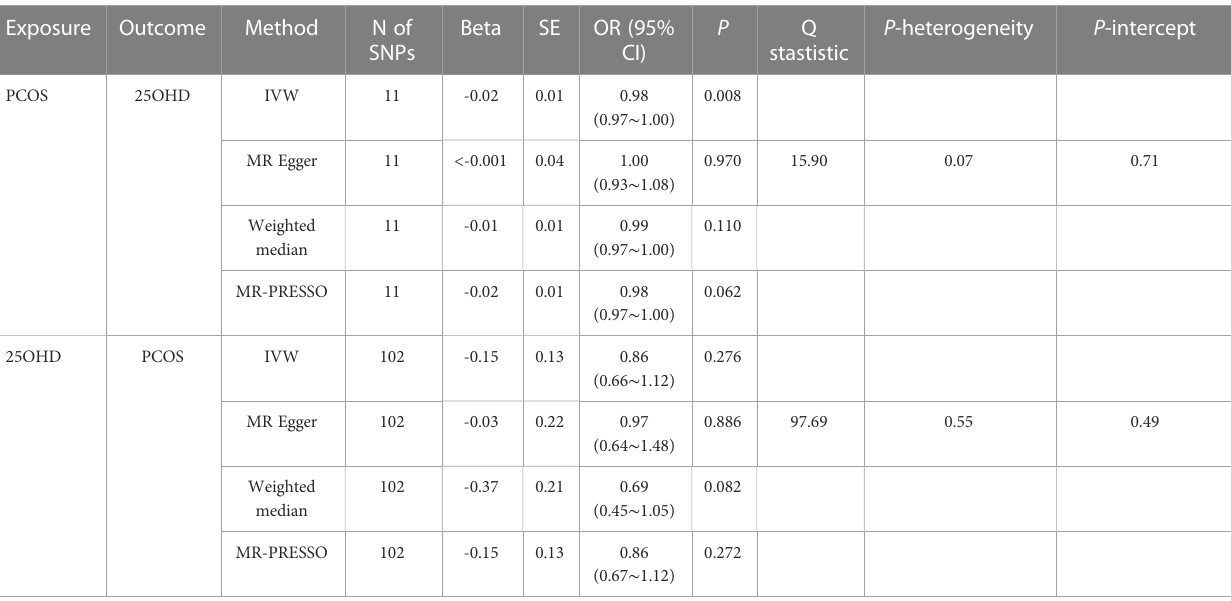
PCOS, polycystic ovary syndrome; 25OHD, 25-Hydroxyvitamin D; IVW, inverse-variance weighted; MR-Egger, Mendelian randomization Egger; SNP, single nucleotide polymorphism; SE, standard error; OR, odds ratio; 95% CI, 95% con fi dence interval; P-heterogeneity, p-value of heterogeneity test from Cochrane's Q value; P-intercept, p-value of pleiotropy test from MR-Egger